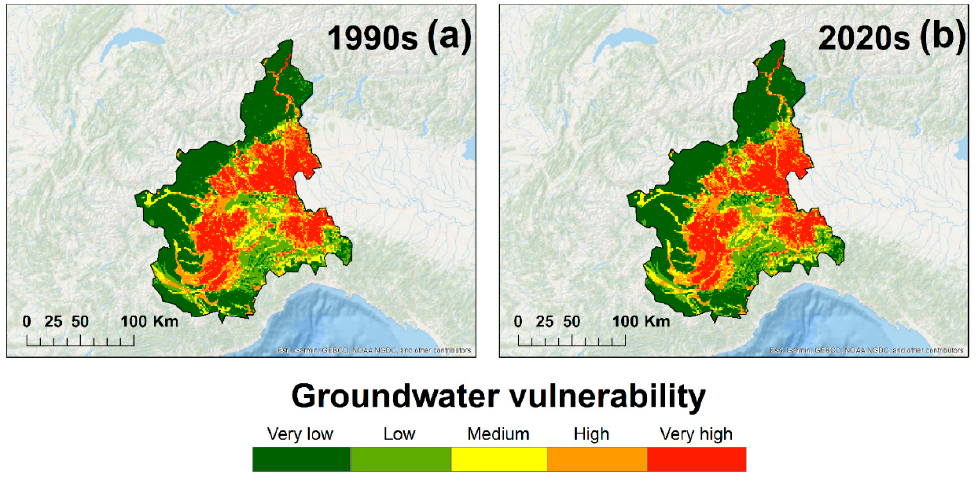
Figure 6. Groundwater vulnerability maps of the Piedmont region. ( a ) Vulnerability map related to the past period (1990s); ( b ) Vulnerability map related to the present period (2020s). Background image source: Esri, Garmin, GEBCO, NOAA NGDC, and other contributors.